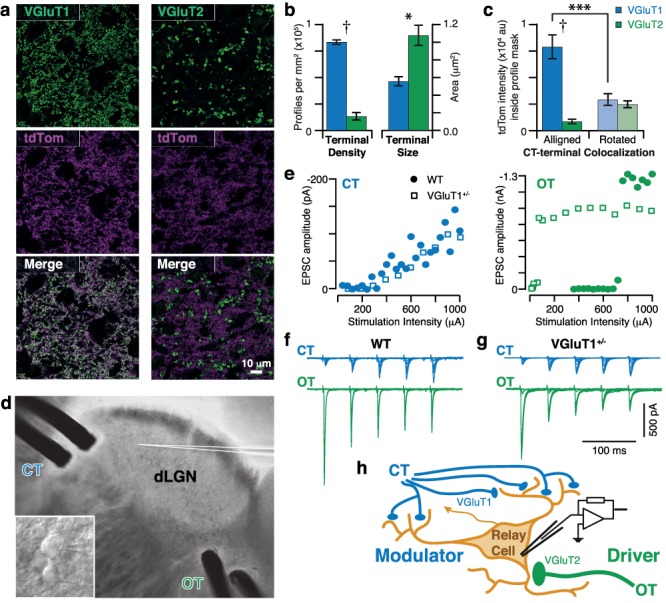
Dichotomy in VGluT expression and basic response properties of OT and CT inputs to dLGN. (a) Representative confocal images of immunostained dLGN sections from an Ntsr1-tdTomato mouse. VGluT1 (left) or VGluT2 (right) immunostaining is shown in green. CT terminals in the dLGN are labeled with tdTomato (magenta). Merged images reveal colocalization (white). (b) Summary of terminal size and density for VGluT1+ (blue) versus VGluT2+ (green) profiles from three Ntsr1-tdTomato mice. Mean ± SEM. Two-tailed t-test values: *, P = 0.014; †, P < 0.0001. (c) Quantification of colocalization between tdTomato and VGluT1+ (blue) versus VGluT2+ (green) profiles from three Ntsr1-tdTomato mice. For each confocal image, a mask was created from the immunostained channel. The total intensity of tdTomato fluorescence within this mask was quantified (left). TdTomato intensity corresponding to random colocalization (rotated) is plotted to the right for both VGluT1+ and VGluT2+ profiles. Mean ± SEM. RM one-way ANOVA P < 0.0001. Sidak’s multiple comparison values: ***, P = 0.0003; †, P < 0.0001. (d) Image of dLGN slice preparation showing positioning of recording and stimulating electrodes. CT inputs were stimulated with a bipolar electrode at the rostral margin of the dLGN. Retinal inputs were stimulated with an electrode where OT fibers cross into the dLGN. A patch-clamp electrode (white lines) was used to record from a dLGN relay cell (magnified, inset). (e) Sample recruitment curves following stimulation of CT (blue, left) or OT (green, right) inputs to dLGN relay cells in WT (solid symbols) or VGluT1+/− (open symbols) mice. EPSC amplitudes from EPSC1 of five-pulse trains (shown in f and g) during incremented stimulus intensity. (f) Example traces recorded from a WT relay cell. Multiple traces with increasing stimulus intensity are overlaid. Stimulus trains of five pulses (20 Hz) illustrate the characteristic patterns of facilitation or depression observed upon stimulation of CT or OT inputs, respectively. (g) Same as in f performed in slices from a VGluT1+/− mouse. Illustrating that CT input continued to produce facilitating responses and OT inputs remained depressing in these mice. (h) Illustration of the dichotomy between CT and OT inputs to relay cells. CT inputs to relay cells are quintessential modulator-type synapses, while OT inputs are driver-type synapses. Anatomical data suggests that CT and OT inputs rely on VGluT1 (blue) and VGluT2 (green), respectively.